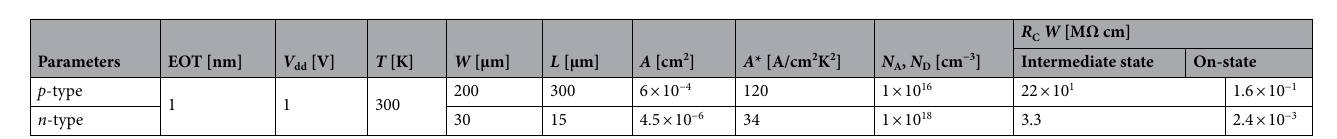
Figure 4. ( a ) Schematic device structure of dual-channel p -type ternary graphene barristor with a CRL and CDL. ( b ) Transfer curves for each channel and the ternary device at V d = − 2 V. V th of the ternary device is defined as the cross points of the off-current level and the transition current tangent. ( c ) Transfer curve of the ternary device on a linear scale and its fitting result. ( d ) Transfer curve of a p -type ternary device modelled with EOT = 1 nm and V d = − 1 V.